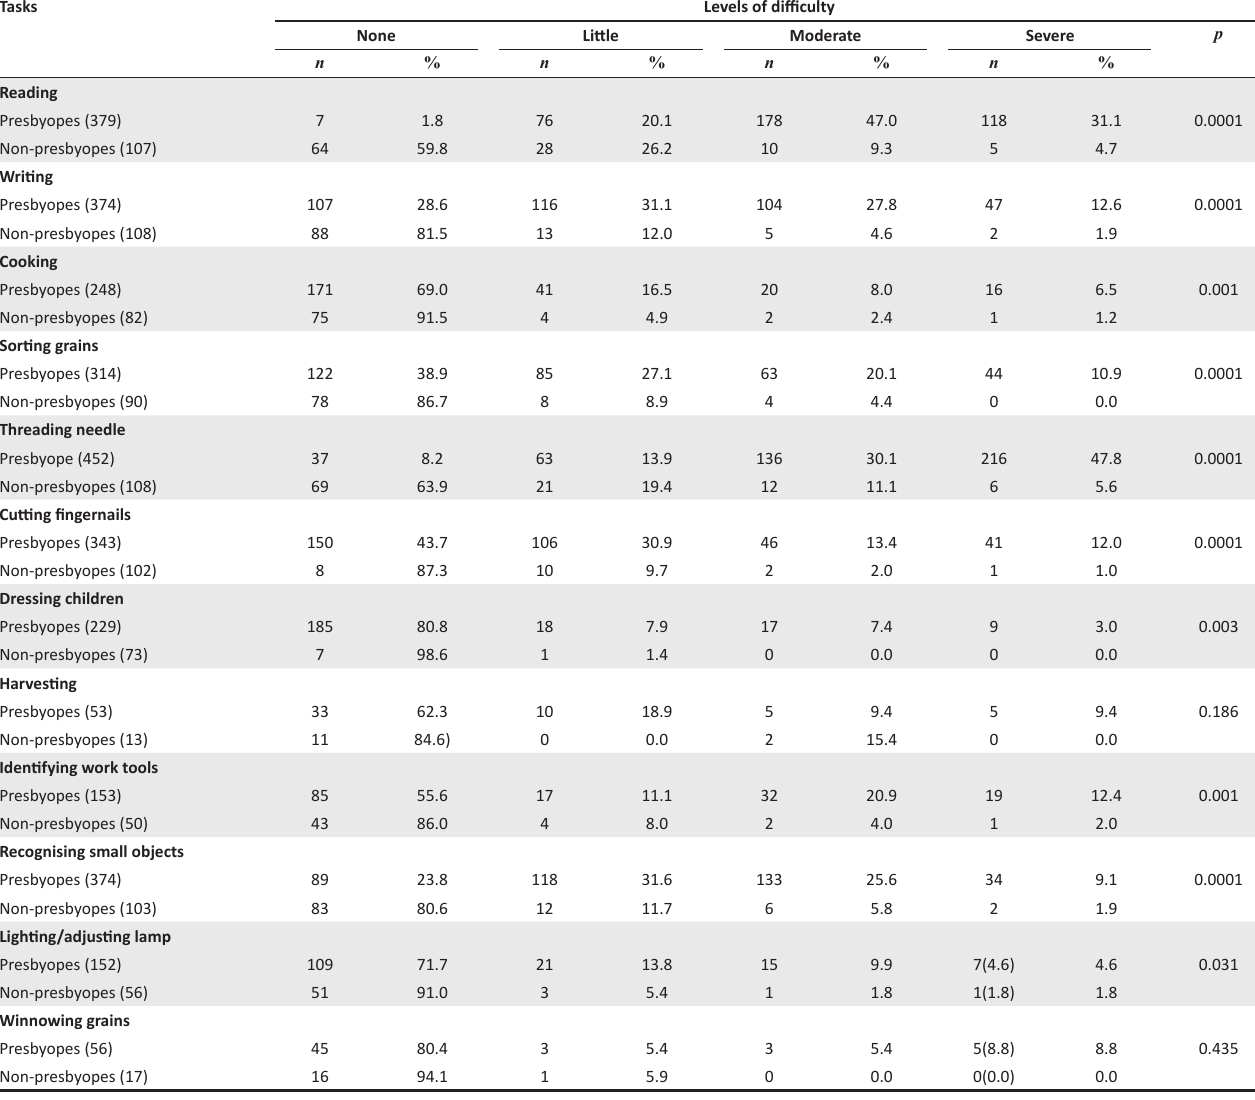
TABLE 5: Comparison of difficulty in near-vision tasks between presbyopes and